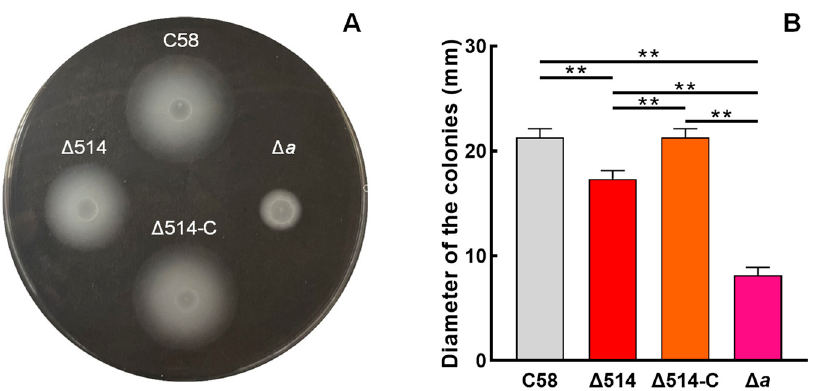
Figure 3. Effect of MCP 514 deficiency on the chemotactic response of A. fabrum . The tested A. fabrum strains were grown to middle-log phase. Bacterial cells were collected and resuspended to the same OD 600nm (0.6). Equal amounts of cells from these cell suspensions were inoculated on the swim plates. The plates were incubated at 28 °C for 2 days. ( A ) Typical colonies of these tested A. fabrum strains. ( B ) The swim-ring diameters of these tested A. fabrum strains on the swim plate. The data represent the means ± SDs from five independent experiments in triplicate. The bars paired with two asterisks “**” represent that they are statistically different at p < 0.01 via the one-way ANOVA, followed by Tukey test. C58, A. fabrum wildtype C58; Δ 514, MCP 514 -deficient mutant; Δ 514-C, Δ 514 mutant complemented with MCP 514 through plasmid; Δ a , CheA-deficient mutant (a control of chemotaxis deficiency).